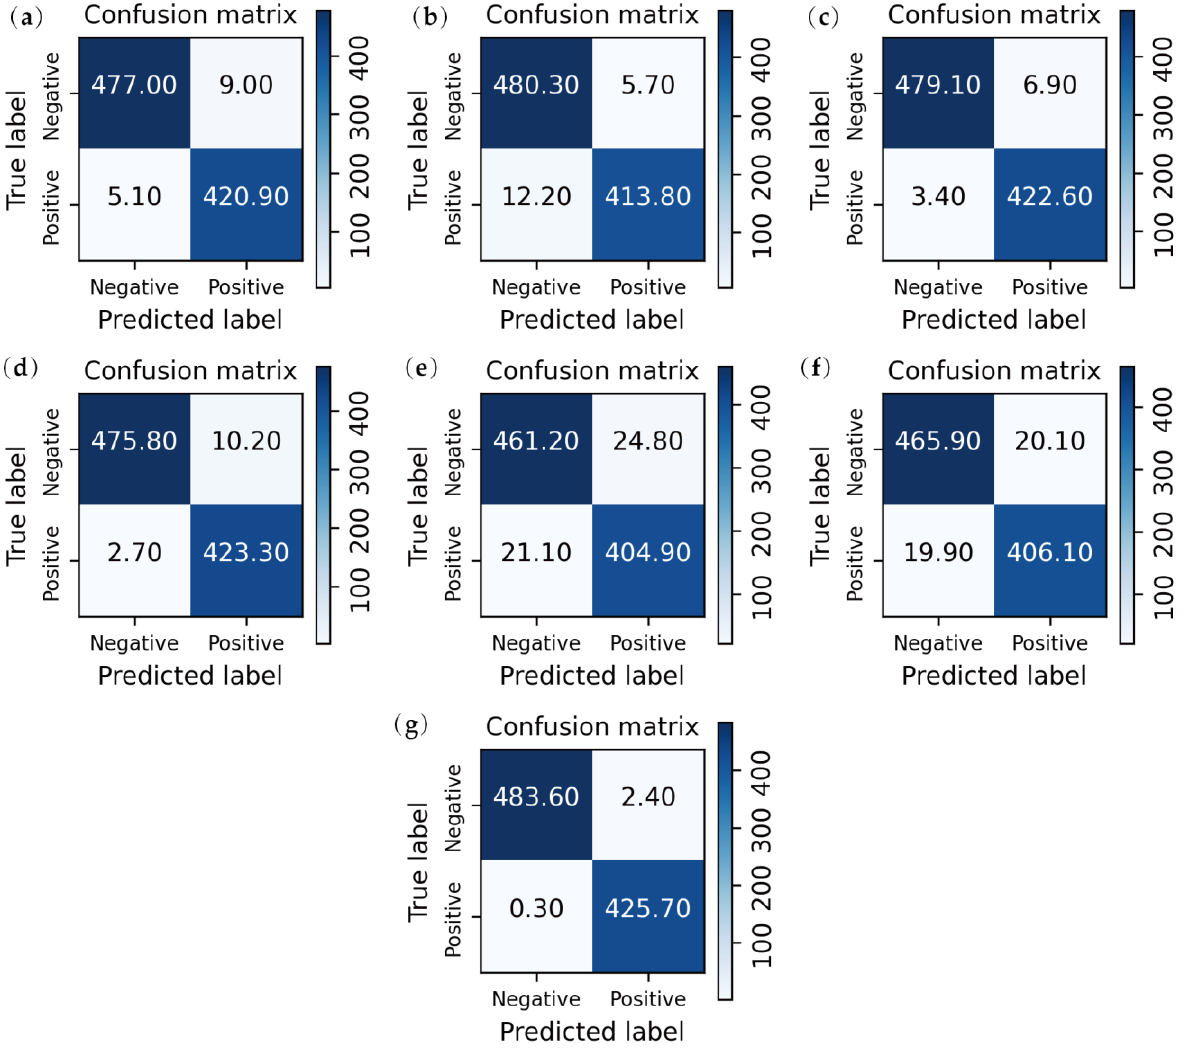
Figure 13. Average confusion matrix. Sub-figures ( a – g ) correspond to models 1–7 in Table 7, respec- tively.